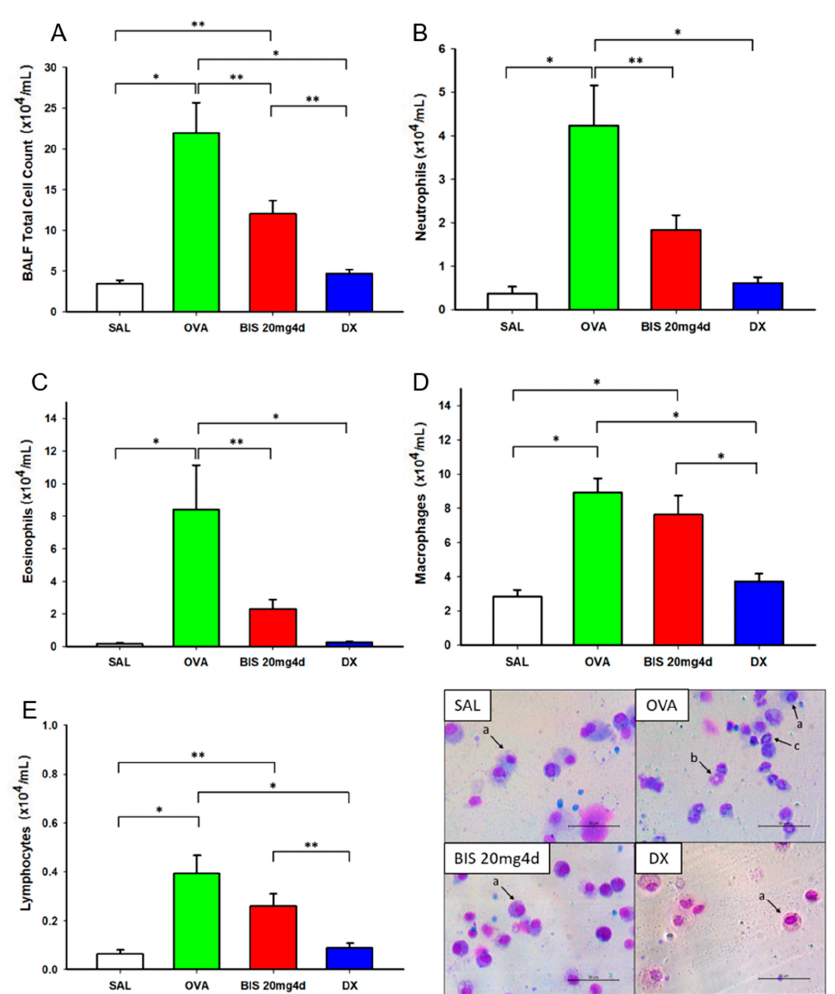
Figure 4 . Effects of biseugenol on BALF inflammation and optical microscope images obtained at 40× zoom. ( A ): Total cells; ( B ): Neutrophils; ( C ): Eosinophils; ( D ): Macrophages; ( E ): Lymphocytes